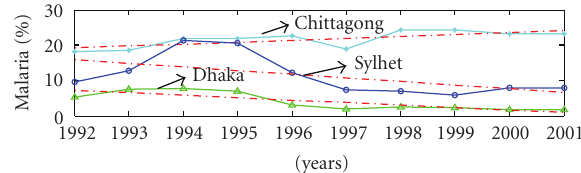
Figure 3: Annual malaria cases in Chittagong, Dhaka, and Sylhet divisions and trend line, 1992–2001.